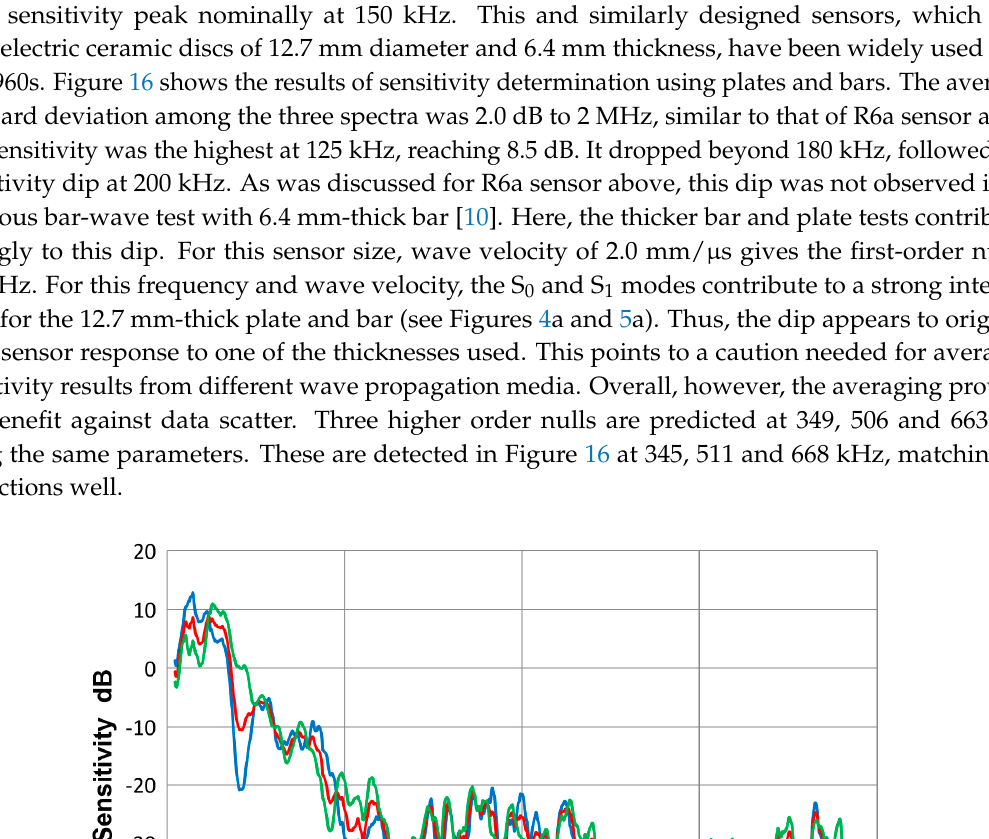
Figure 17. Receiving sensitivity of PAC F30a sensor. Red -averaged guided wave sensitivity, blue - Lamb waves for 12.7 and 6.4 mm plates, green -bar waves for 12.7 and 6.4 mm bars.